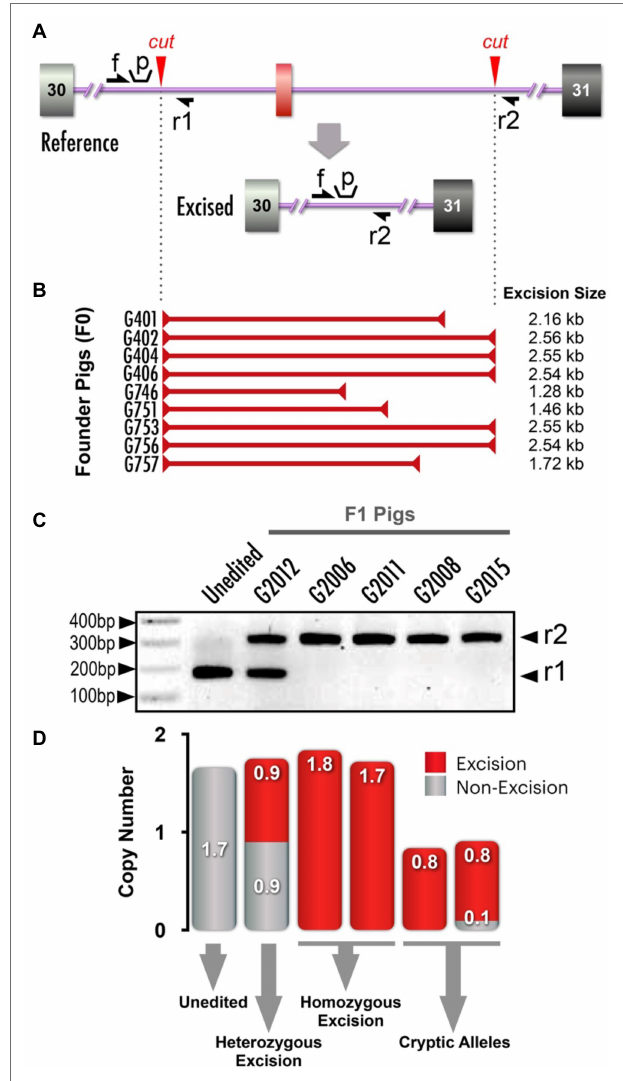
FIGURE 5 | NF1 splicing variants ( NF1 a31 excision) and copy number variance (CNV) analysis. (A) Schematic depicts alterations made within flanking regions of NF1 exon a31. Red arrowheads: Cas9 cut sites, single- headed black arrows (f, r1, r2): primer annealing sites for competitive